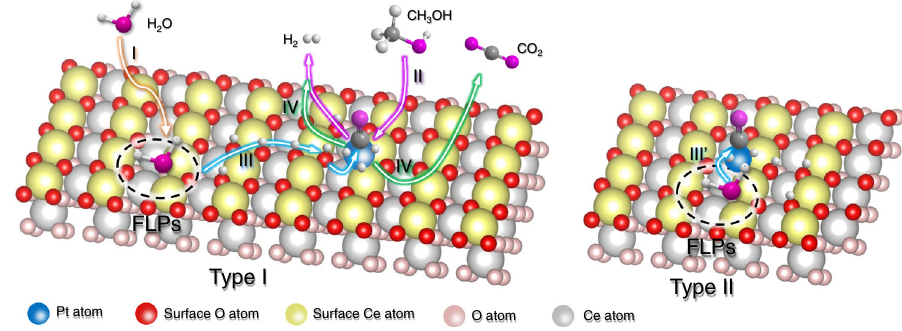
Fig. 6 | Proposed reaction process. Catalytic pathway for H 2 generation from methanol and H 2 O catalyzed by the Pt 1 -FLP dual-active sites constructed on Pt 1 /PN-CeO 2